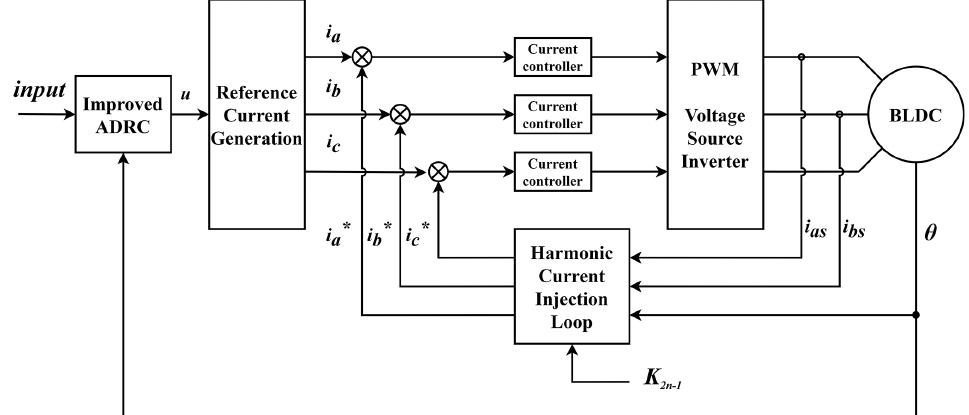
Figure 5. The principle block diagram of the harmonic injection ADRC method.